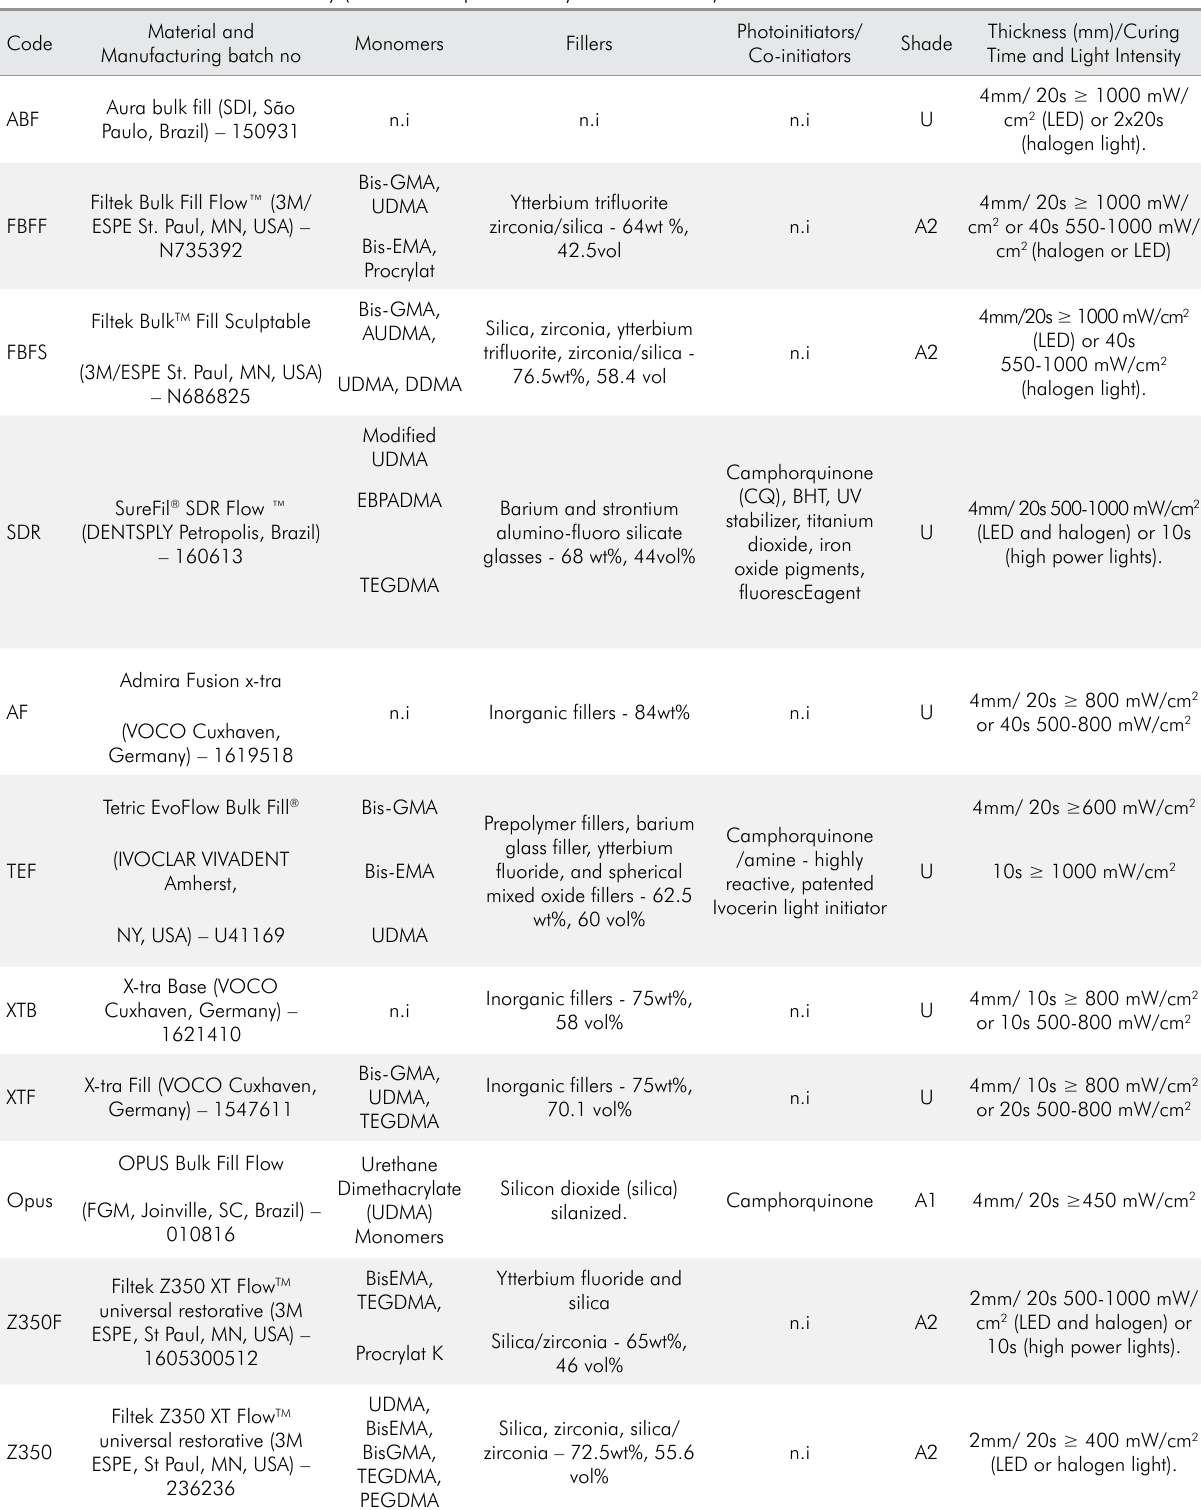
Table 1. Materials used in the study (Information provided by